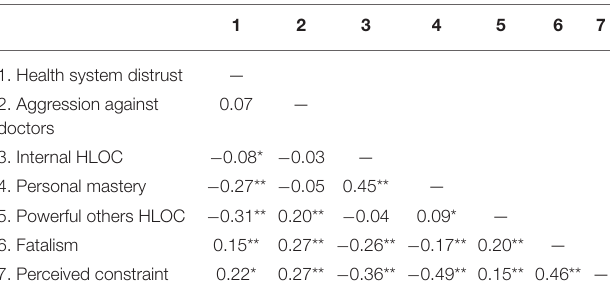
TABLE 2 | Correlations of primary interest for the whole dataset (Study